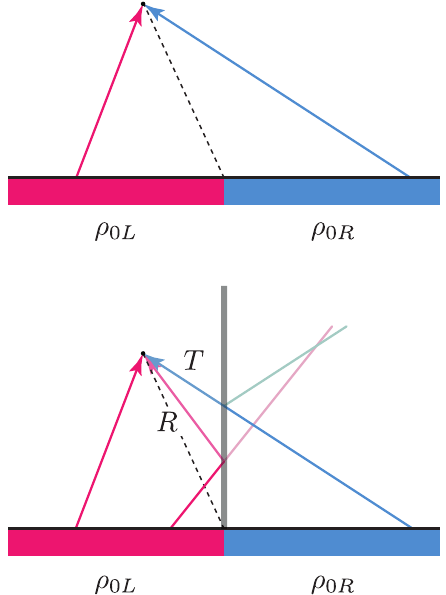
Figure 2: Semiclassical picture for an inhomogeneous quantum quench in the ab- sence ( top ) or presence of a defect at the origin ( bottom